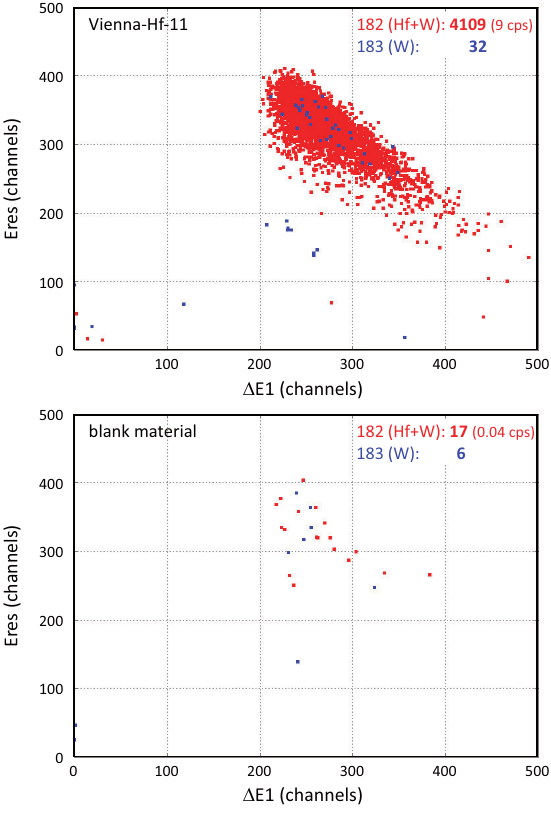
Figure 4. Detector spectra of runs on Vienna-Hf-11 reference material with a nominal ratio of 182 Hf / 180 Hf = 5.88 blank material containing no 182 Hf. Red events were collected with the system tuned for mass 182 (i.e. 182 Hf 3 + and 182 W 3 + ), blue events for mass 183 (only 183 W 3 + and m / q ambiguities). The acquisition time was 455s in all cases. There is a strong surplus of m = 182-events on the reference material.